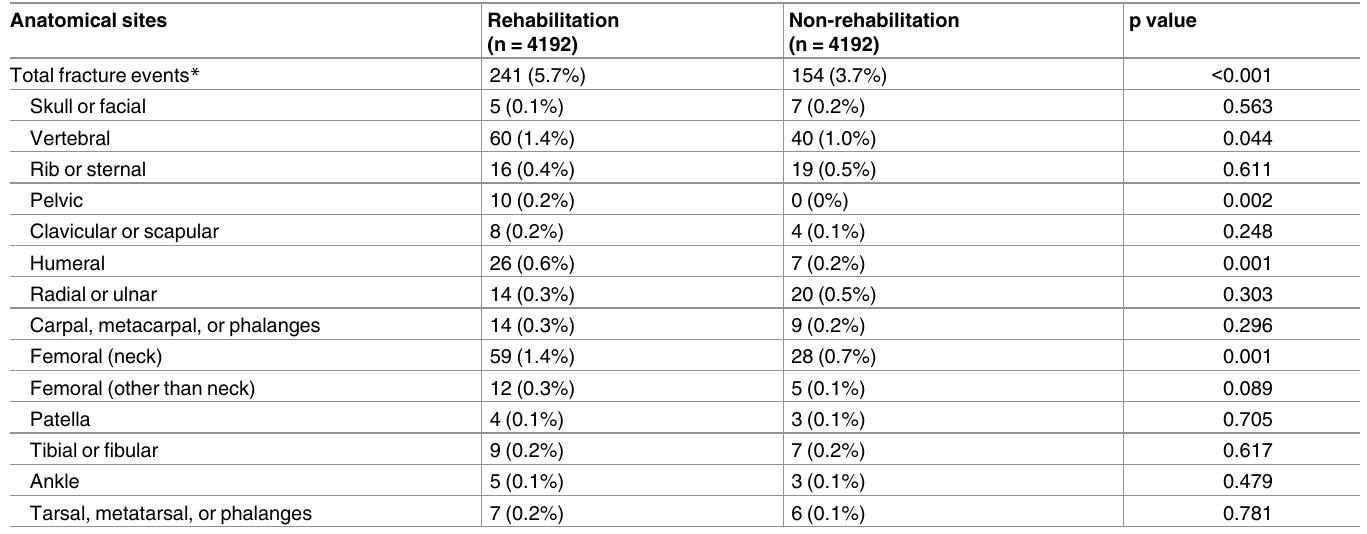
Table 3. Comparison of fracture sites between post-stroke rehabilitation and non-rehabilitation